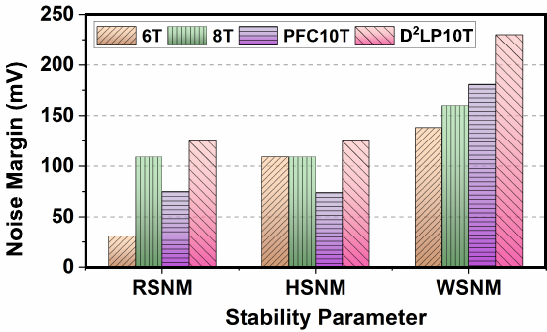
Figure 8. Stability analysis of different SRAM cells at VDD of 0.4 V.